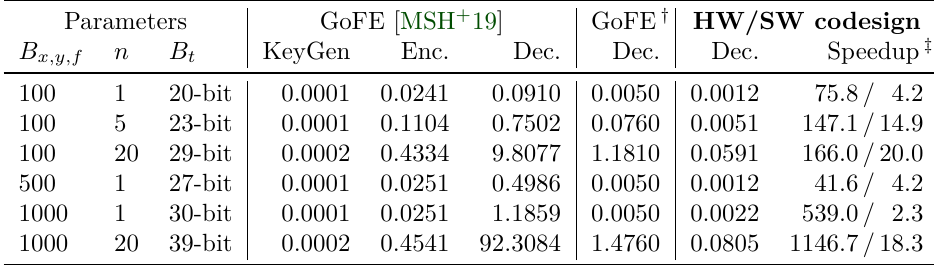
= n 2 · B . t x · B y · B f